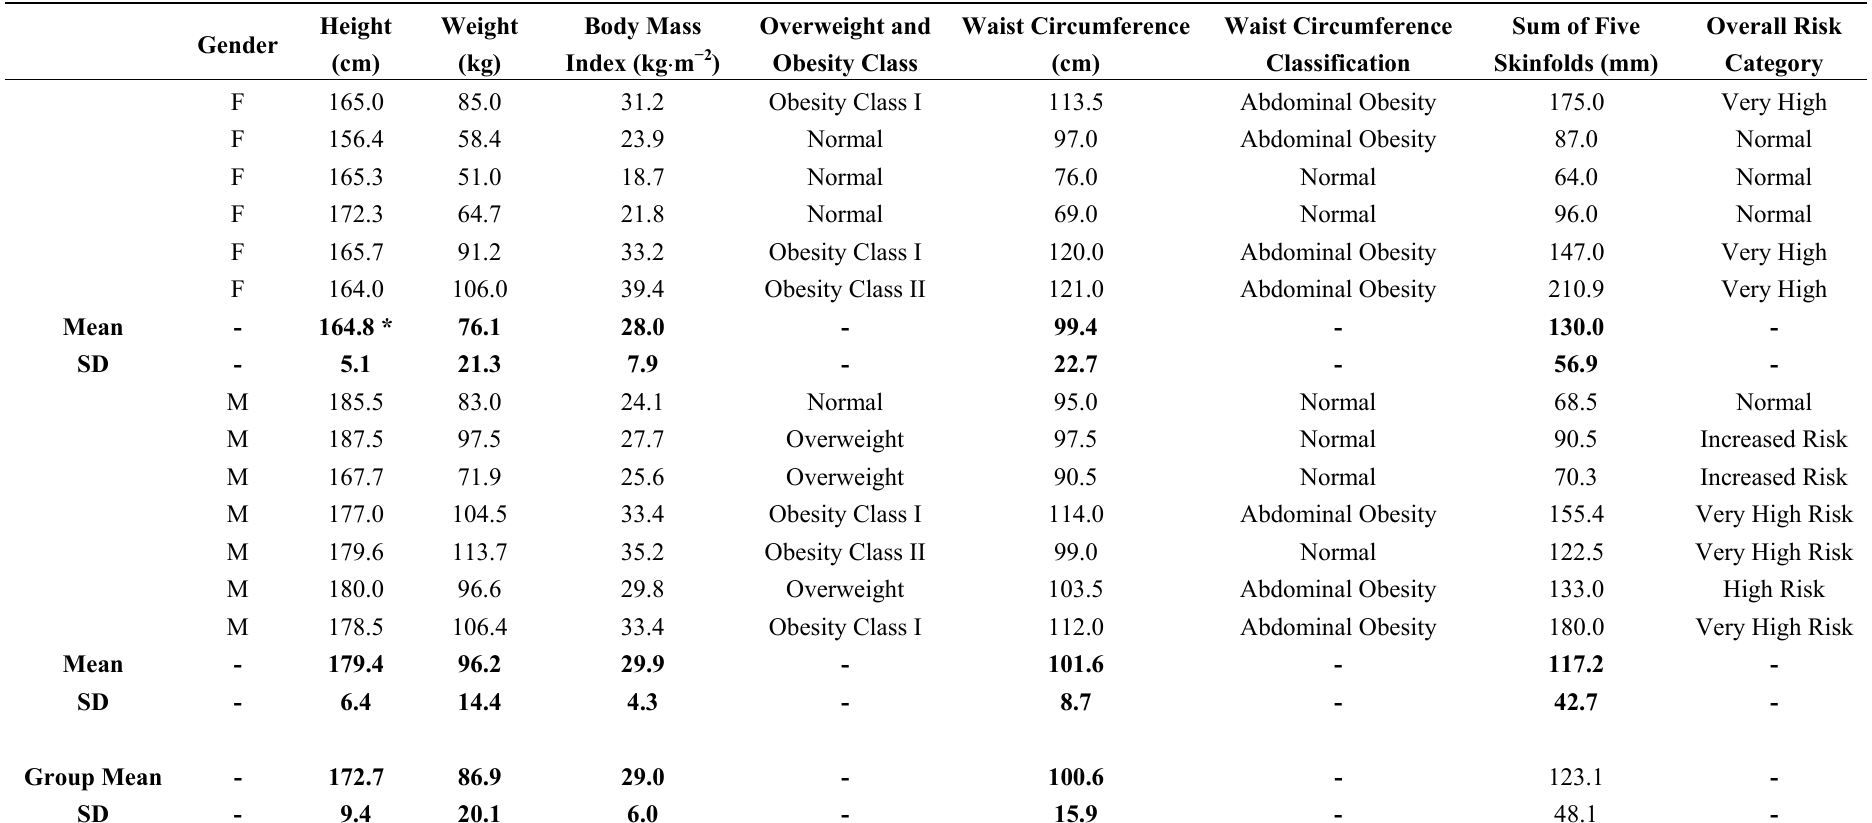
Table 5. Anthropometric characteristics of 13 participants at